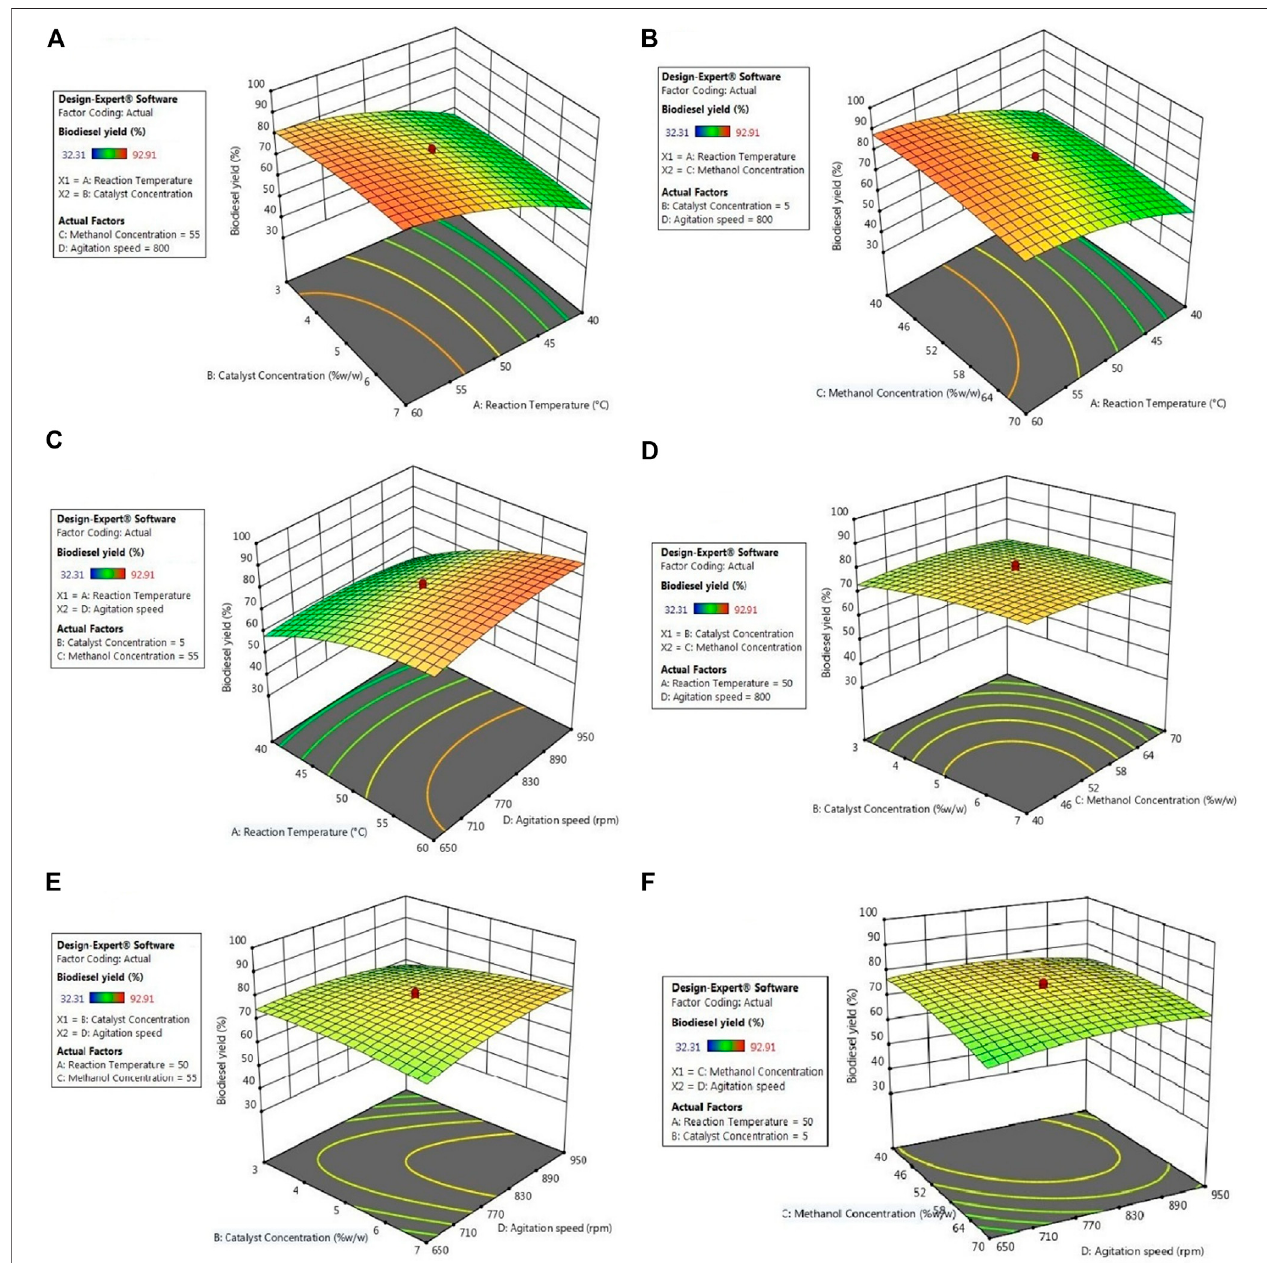
FIGURE 5 | Contour plots of interactive impacts on biodiesel yield (A) reaction temperature and catalyst concentration (B) reaction temperature and methanol concentration (C) reaction temperature and agitation speed (D) catalyst concentration and methanol concentration (E) catalyst concentration and agitation speed (F) methanol concentration and agitation